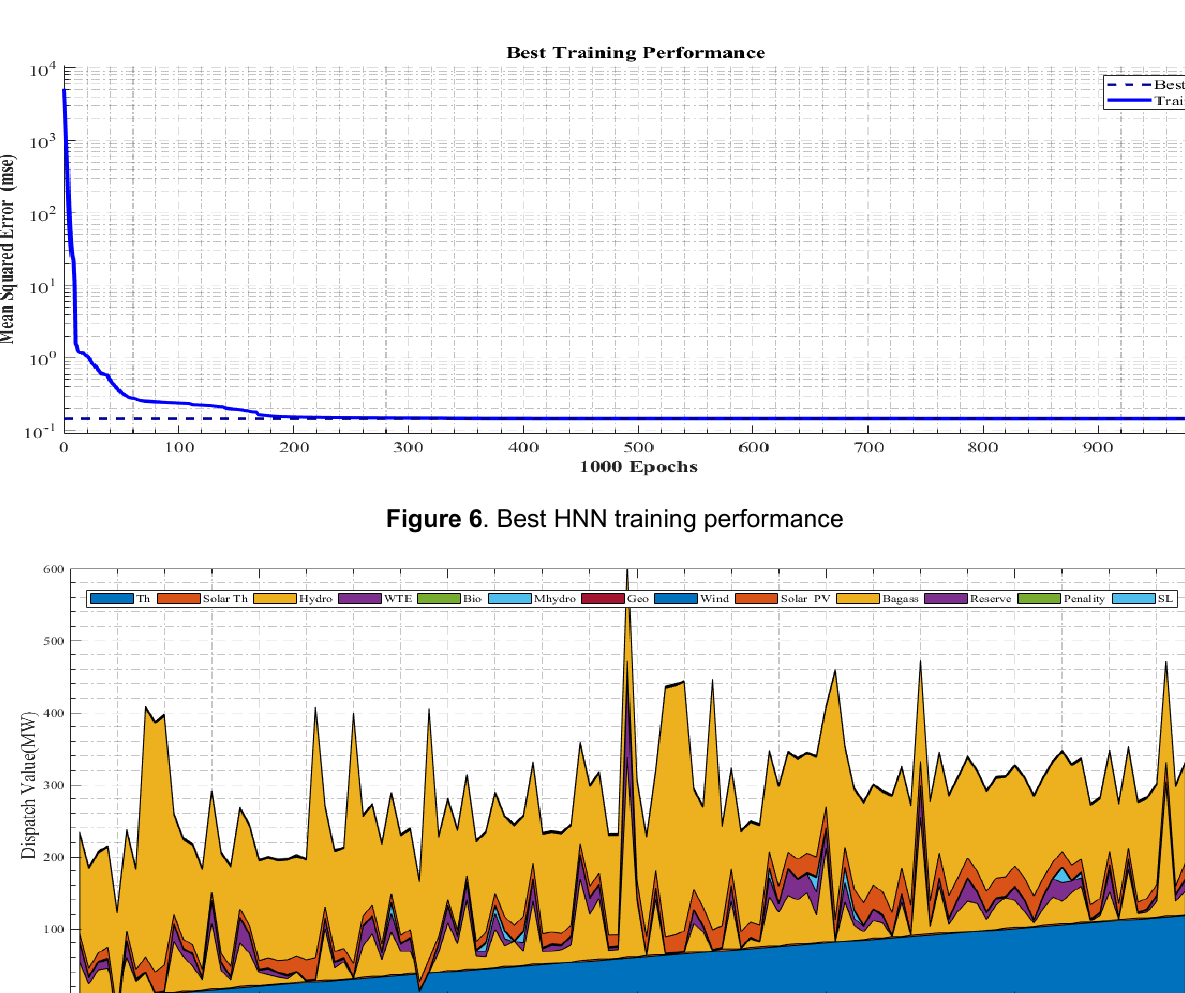
Figure 5 . Dispatch contributions from Ethiopian existing power plant